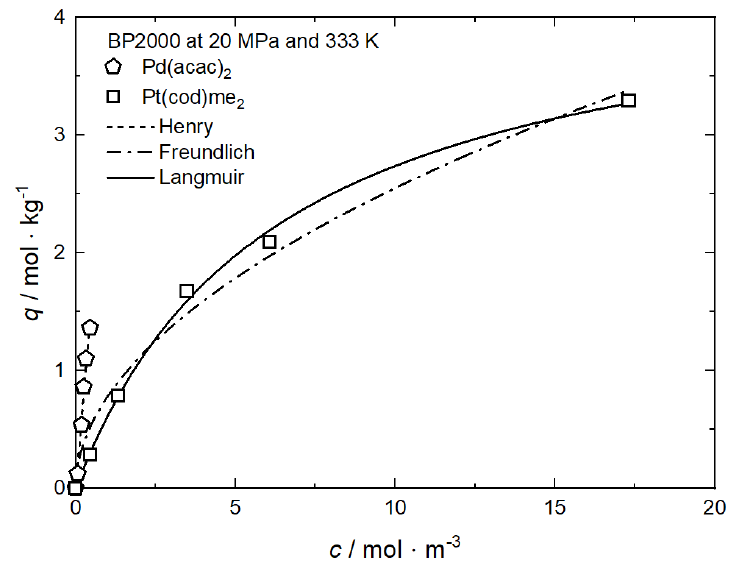
Figure 14. Uptake of different precursors on BP2000 at 20 MPa and 333 K; experimental data taken from [8]. Table 11. Adsorption isotherm parameters for different precursors from scCO 2 solution on BP2000 at 20 MPa and 333 K [8].